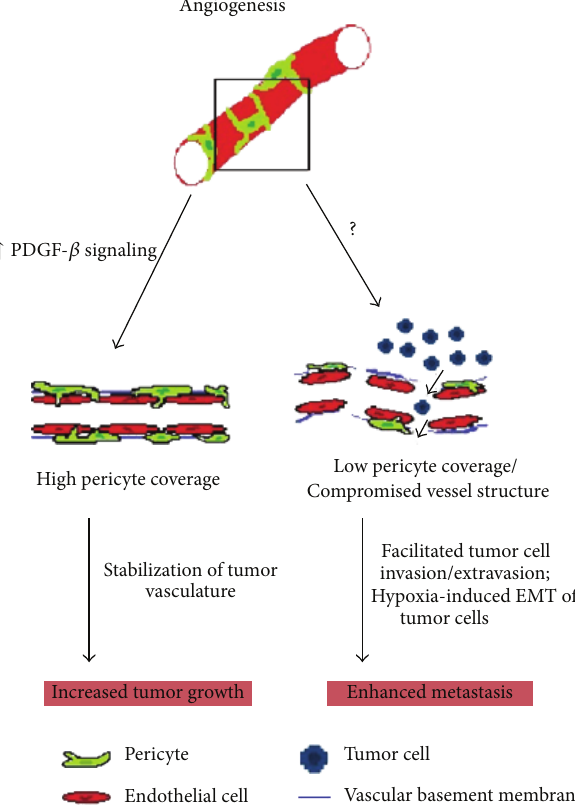
Figure 1: Abnormal pericyte coverage of tumor vessels affects tumor development. PDGF- 𝛽 signaling controls pericyte recruit- ment during angiogenesis. Hyperactivation of this pathway within TMEmayincreasepericytecoverage,therebyimprovingvasculature stability and perfusion, which favors tumor growth. In contrast, low pericyte coverage compromises vessel structure integrity, which becomes leaky, facilitating tumor cell invasion/extravasion. Under such circumstances, tumor cells may also undergo EMT induced by hypoxia, as a consequence of lower perfusion in the tumor vasculature. Both situations enhance metastatic spread of tumor